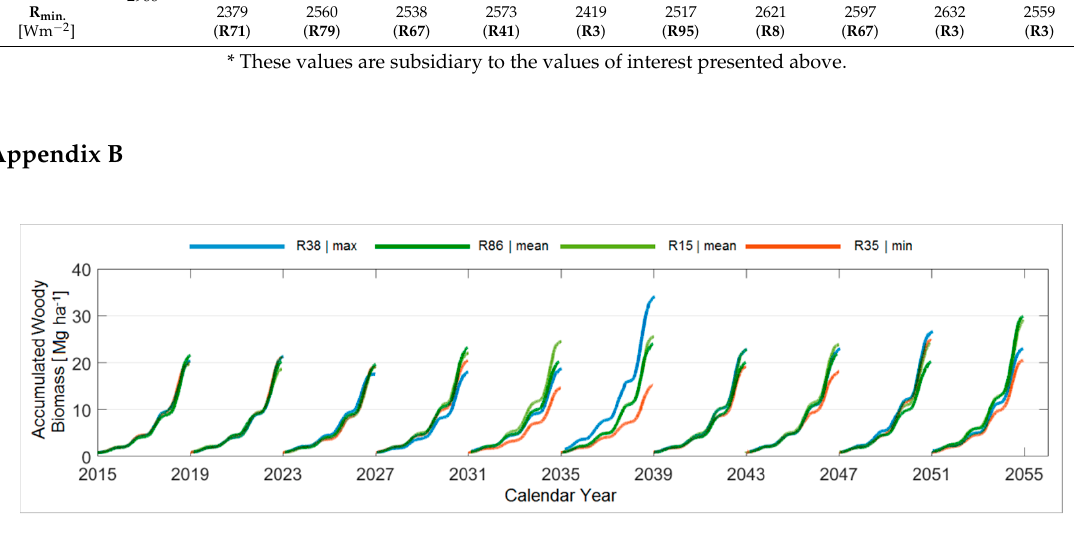
Figure A1. Projected accumulated woody biomass of poplar trees under realisations that rendered minimum (R35, orange), mean (R15, light green; R86, dark green), and maximum (R38, blue) average temperature values during the vegetation period from 2015 to the end of 2054. Forests 2018 , 9 , x FOR PEER REVIEW